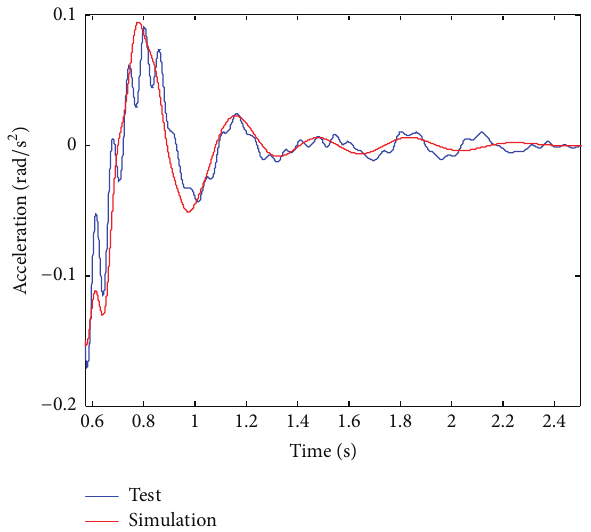
Figure 8: Comparison of the pitch angle acceleration of testing with the one of simulation in pitch test.